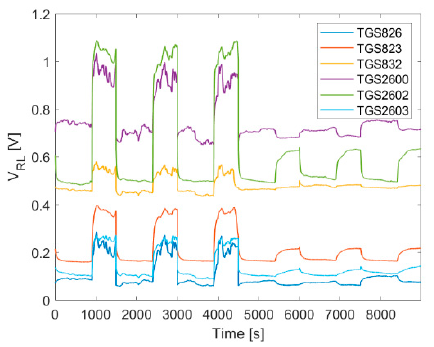
Figure 12. Sensor signals change due to wetting of the first step filter. Wetting took place after the third test measurement.